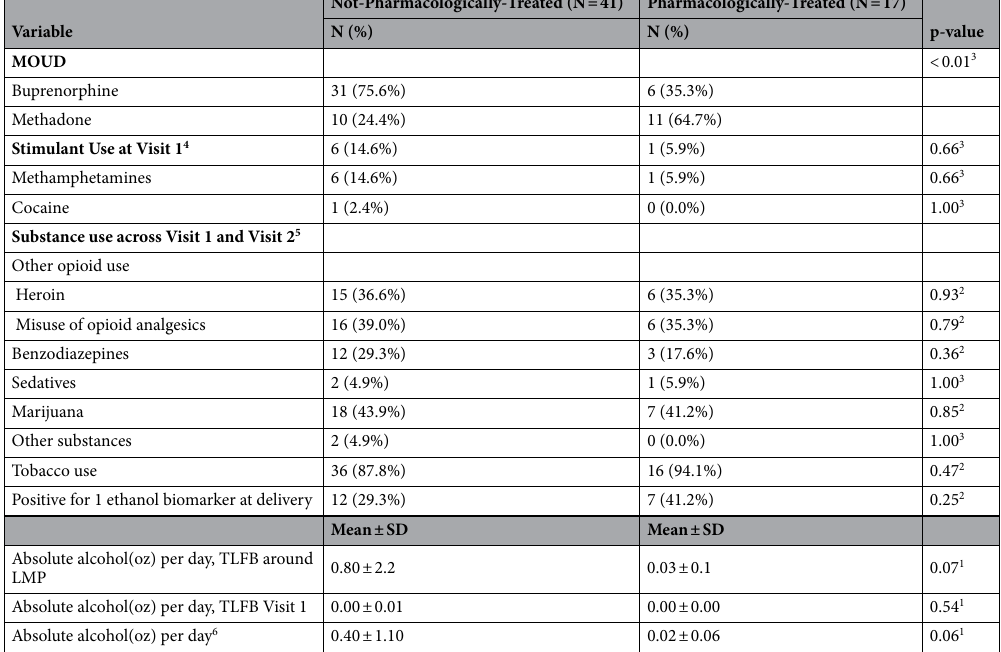
Table 2. Maternal substance use patterns. LMP last menstrual period, MOUD medications for opioid use disorder, NOWS neonatal opioid withdrawal syndrome, SD standard deviation, TLFB timeline follow- back. 1 Based on Mann–Whitney test. 2 Based on Chi-square test. 3 Based on Fisher’s exact test. 4 Any use of methamphetamines, cocaine, crack, MDMA, PCP, or other inhalants (more than occasional use of stimulants anytime in pregnancy and any use after the first trimester) were exclusionary criteria; stimulants not shown had no evidence of use. 5 Visit 1 occurred prenatally and Visit 2 occurred at delivery/birth. 6 Average use from 2 TLFB calendars (around LMP and Visit 1).